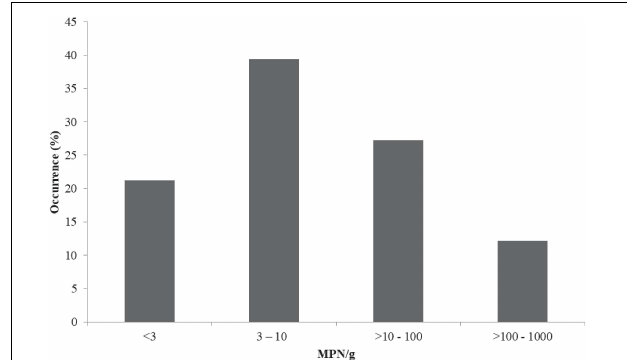
FIGURE 1 | Levels of V. parahaemolyticus in African salads. MPN/g, most probable number per gram; < , less than; > , greater than.